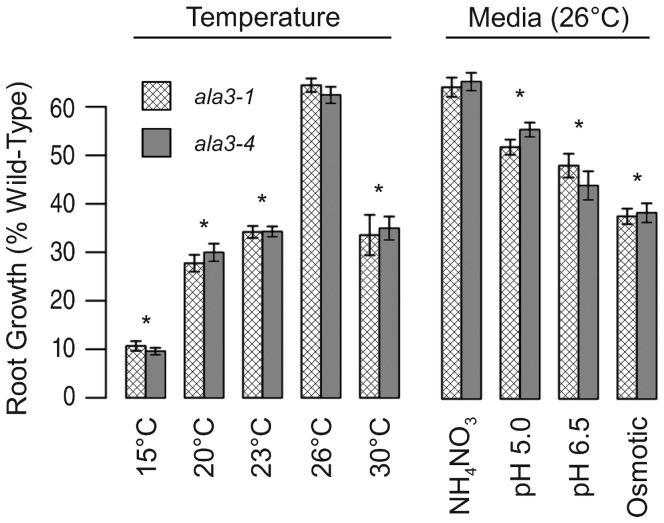
The length of ala3 roots relative to wild-type varies with growth conditions.Seedlings were grown under 24 h fluorescent light on ½×MS media until the longest roots reached the bottom of the plate (∼7 cm). The column labels represent the conditions used in the assays. For experiments testing variations in growth media, plants were all grown at 26°C and media was amended with either 15 mM NH4NO3 (pH 5.7), KOH to adjust media to pH 5.0 or 6.5, or 4.5% sucrose to create an osmotic challenge. Root lengths were normalized to the wild-type mean and average results (±SE) for three independent experiments (n≥19 for all conditions except: n = 9 for 15°C, and n = 6 for 30°C) are presented for ala3-1 (crosshatched bars) and ala3-4 (filled bars). * Significantly different from ala3 root growth at 26° on unmodified media (p<0.05, Welch’s t-test).